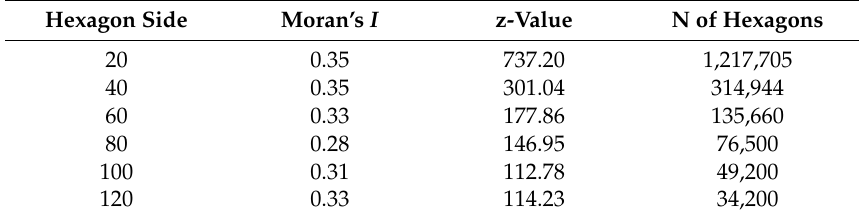
Table 1. Change of Moran’s I of the fear of crime data with increasing length of the hexagon side. Hexagon Side